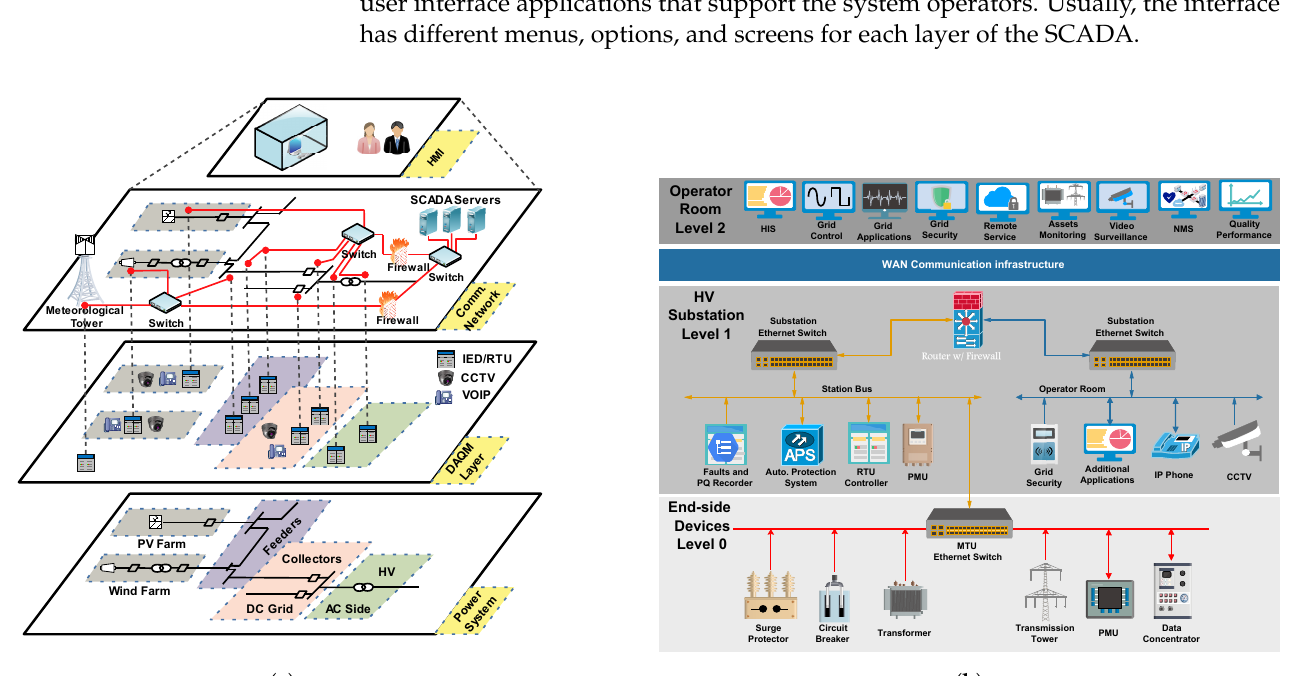
Figure 1. The layers of transmission systems SCADA. ( a ) The four layers of a power system SCADA. ( b ) SCADA in HV Transmission